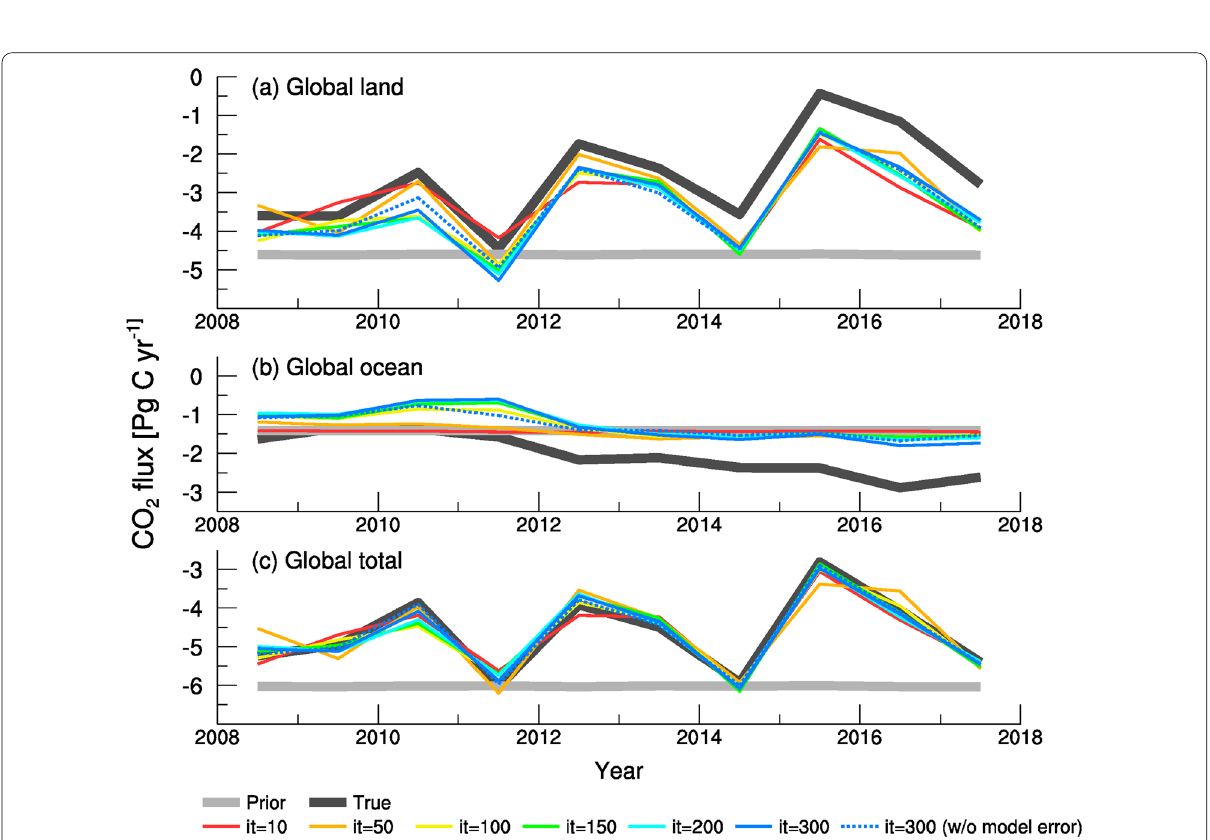
Fig. 12 Yearly variations of the global land ( a ), ocean ( b ), and total ( c ) CO 2 fluxes. (Fossil fuel emissions are excluded.) Light-gray and dark-gray solid lines represent the prior and true fluxes, respectively. The other colors indicate posterior fluxes from different iterations (10–300) of CTL. The blue dotted line denotes the 300th iteration result where model errors are nonexistent